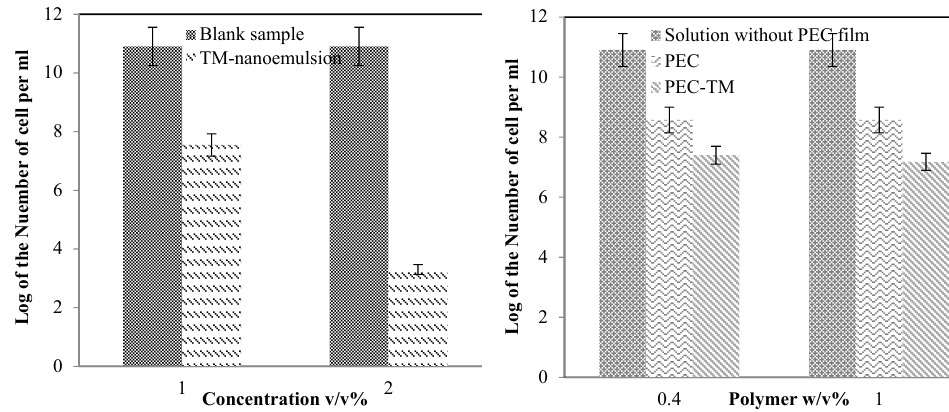
Figure 7. Antibacterial activities of TM-PEC films and TM-nanoemulsions against E.coli .